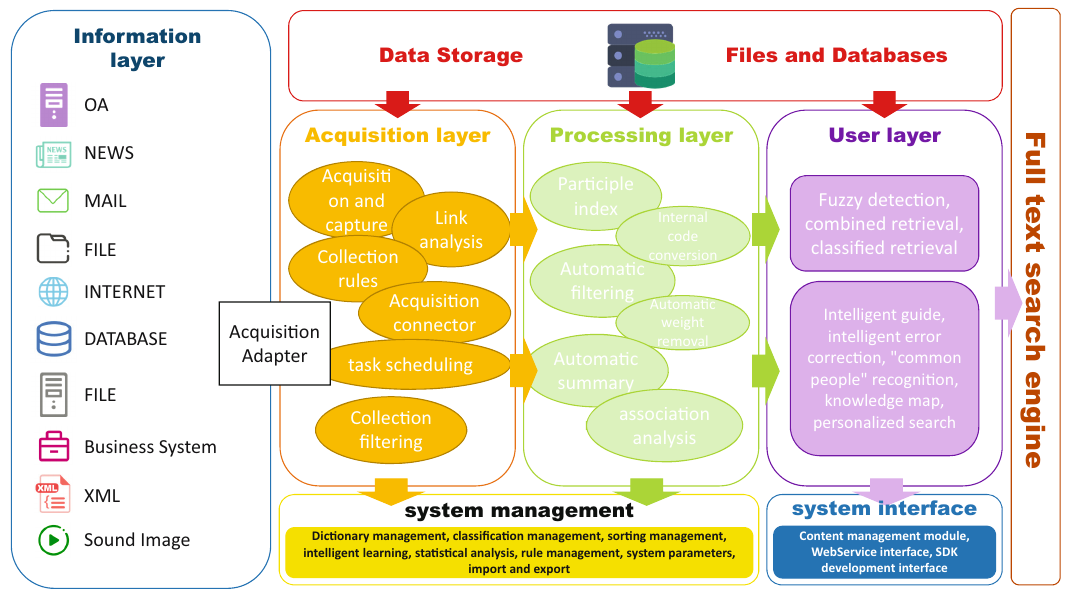
Figure 1: Capacity and fl ow distribution in the computer communication